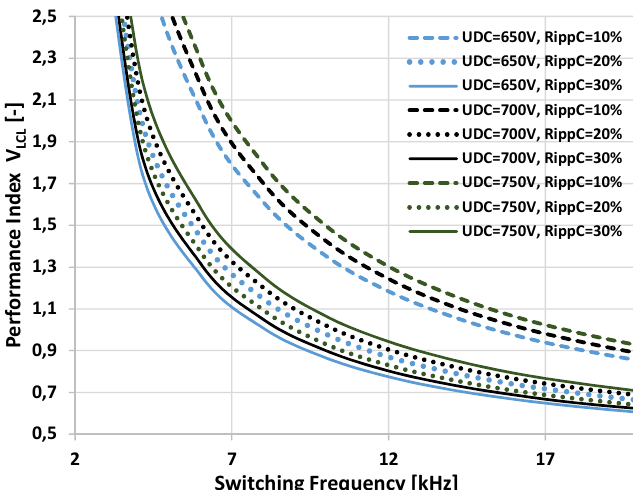
Fig. 5. Variations of V LCL performance index for different switching frequencies with changes of U DC and RippC parameters. Analysis performed for 14 kVA converter